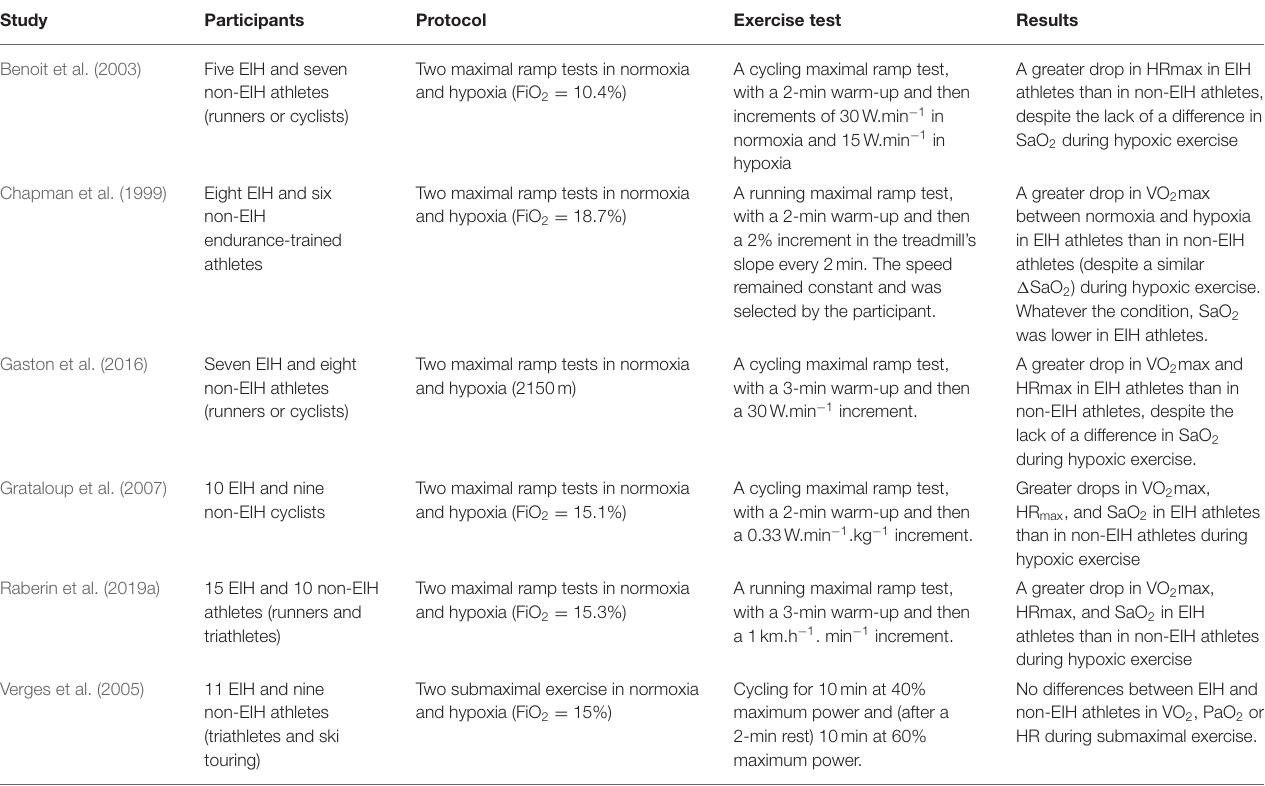
TABLE 1 | Summary findings of studies of EIH athletes exercising under acute hypoxic conditions.